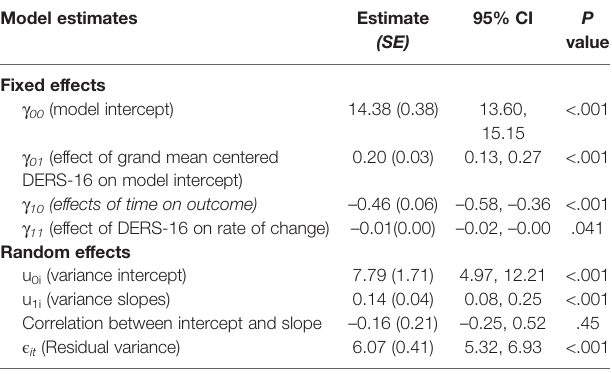
TABLE 3 | Effects of baseline scores of DERS-16 on rate of change in QIDS- A17-SR: parameter estimates, standard errors, 95% con fi dence intervals, and p-values (n = 67).